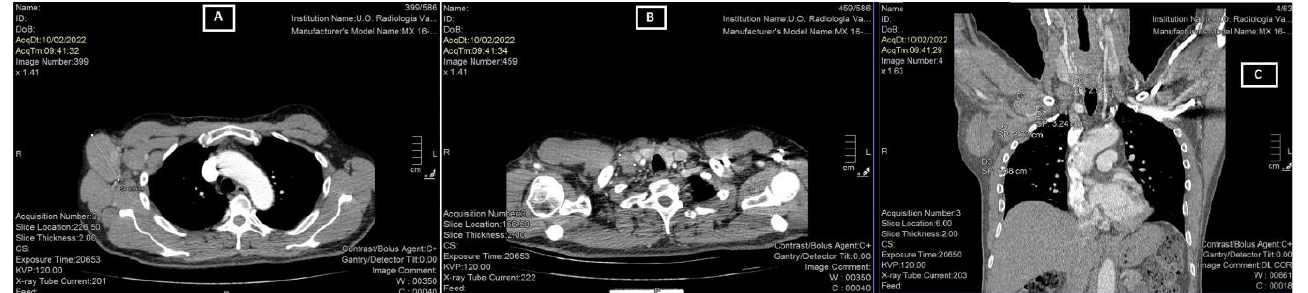
cm, respectively (Figure 2).